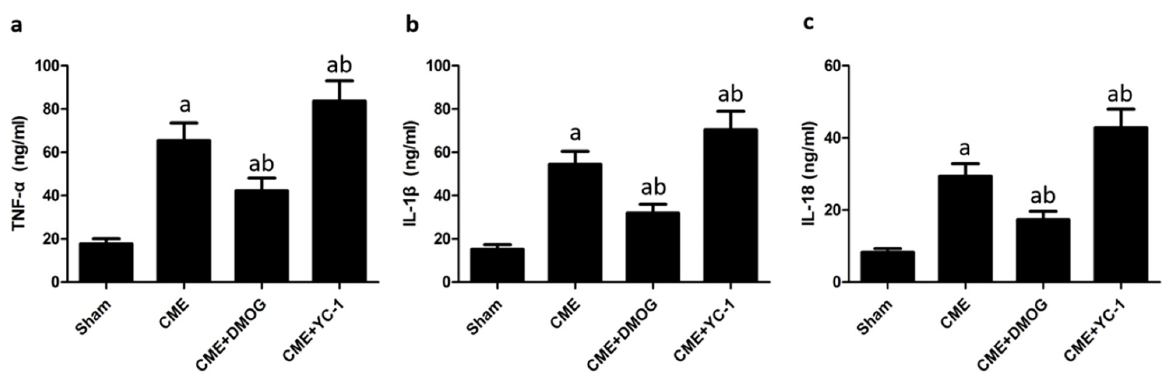
Figure 3 . Effects of HIF-1α on serum levels of TNF-α (a), IL-1β (b), and IL-18 (c). Serum TNF-α, IL-18, and IL-1β expression levels were increased following coronary microembolization (CME). DMOG inhibited its increase despite CME, whereas YC-1 aggravates these effects. a P <0.05 in comparison to Sham group; b P <0.05 in comparison to CME group. n =